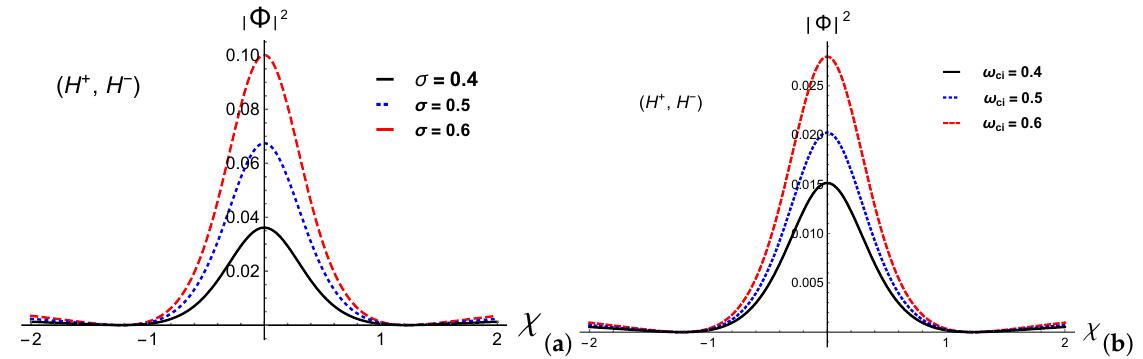
Figure 2. The change of first-order IARWs amplitude versus χ for various values of r with q = 2 ( a ) and q with r = 0.7 ( b ). Here, β 1 = 0.6, β 2 = 0.3, σ = 0.3, and ω ci = 0.3.